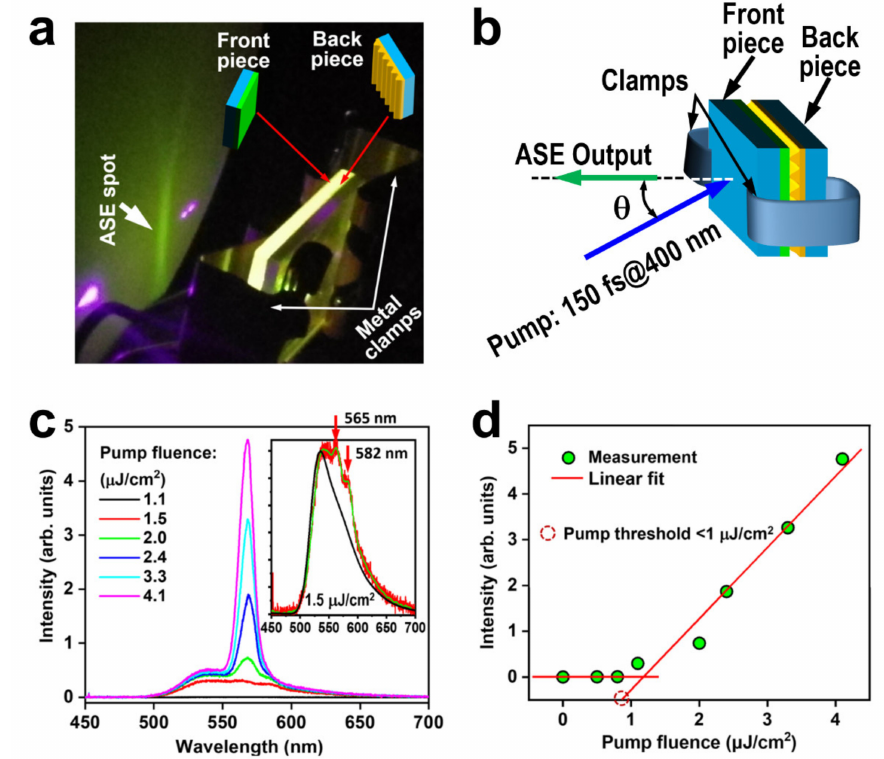
Figure 4. ( a ) Photograph of the experimental setup for characterizing the mechanically contact DFB microcavity and the ASE output generated in such an active microcavity. ( b ) Schematic illustration of the experimental configuration ( θ ≈ 20 ◦ ). ( c ) ASE spectra at different pump fluences. Inset: comparison between the PL spectrum (black) and the emission spectrum (red) at a pump fluence of 1.5 µ J/cm 2 with a guide curve (green). ( d ) Emission intensity as a function of the pump fluence and linear fittings to the measurement data, showing a center wavelength of ASE at 568.3 nm and a threshold pump fluence lower than 1 µ J/cm 2